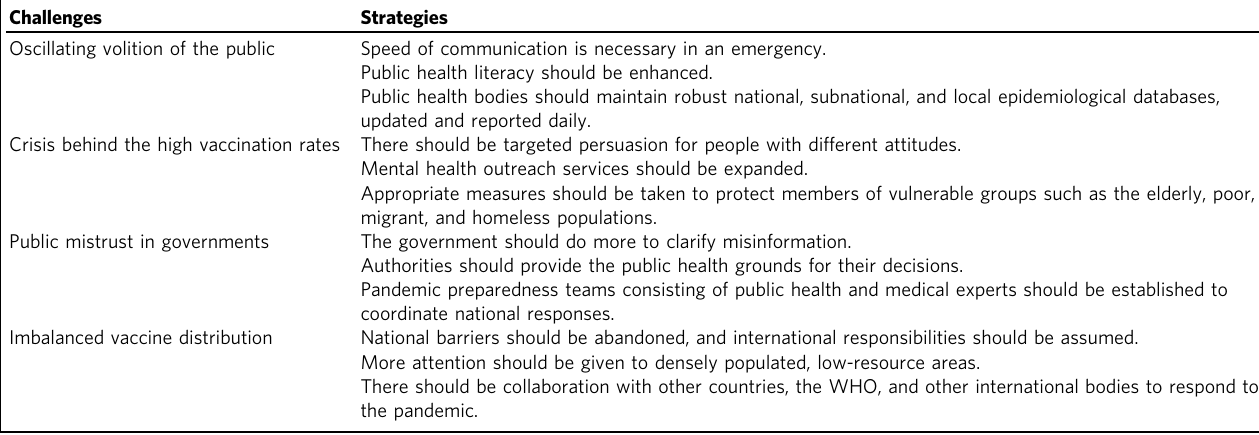
Table 1 Overview of challenges of and strategies for promoting global vaccination.